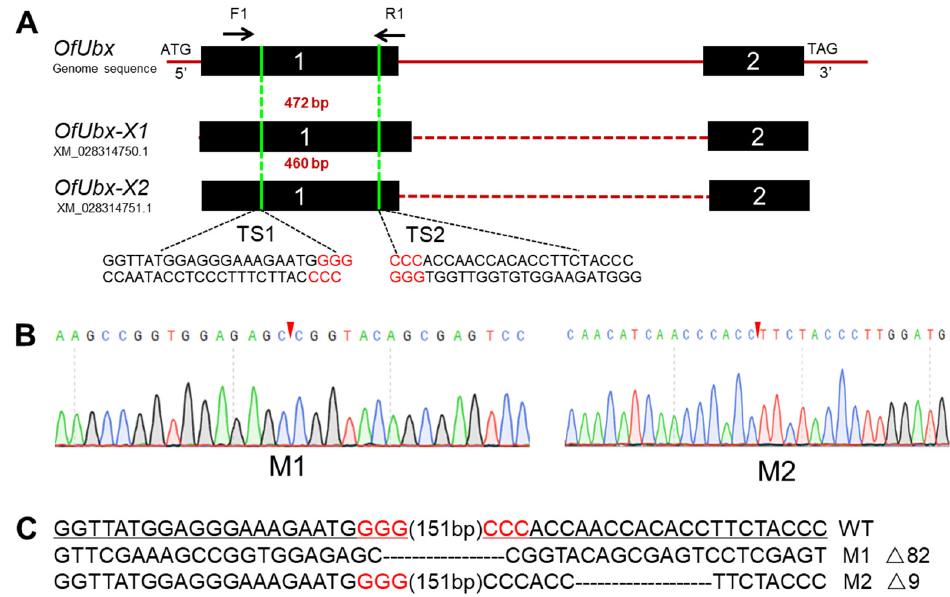
Figure 5. CRISPR/Cas9-mediated mutations within OfUbx target sites. ( A ) The target site of OfUbx genome locus in exon 1 of the common region for the two splice variants. ( B ) Sequencing chroma- togram of OfUbx mutants. The red wedge indicates the position of cleavage by the CRISPR/Cas9 genome editing system. M1 (Mutant1); M2 (Mutant2). ( C ) Genotype detection of OfUbx genome sequence. The PAM sequence is in red. The black line represents the target site. The two target sites are separated by 151 bp.